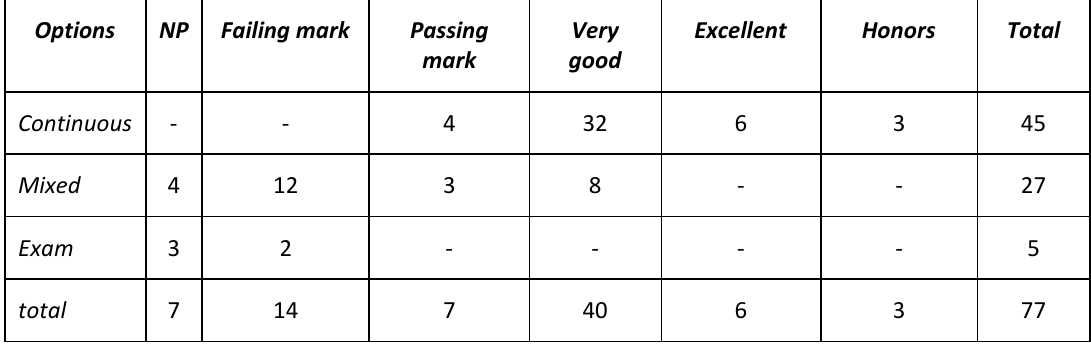
Table 7. Academic Performance in different options